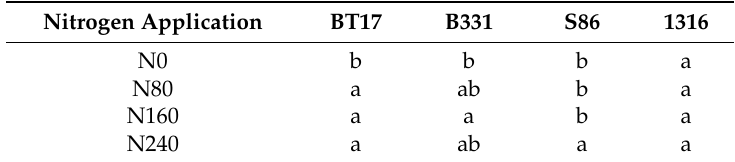
Table 6. Significant difference test results between the average stand volume increments under different nitrogen levels for each clone. Nitrogen Application BT17 B331 S86